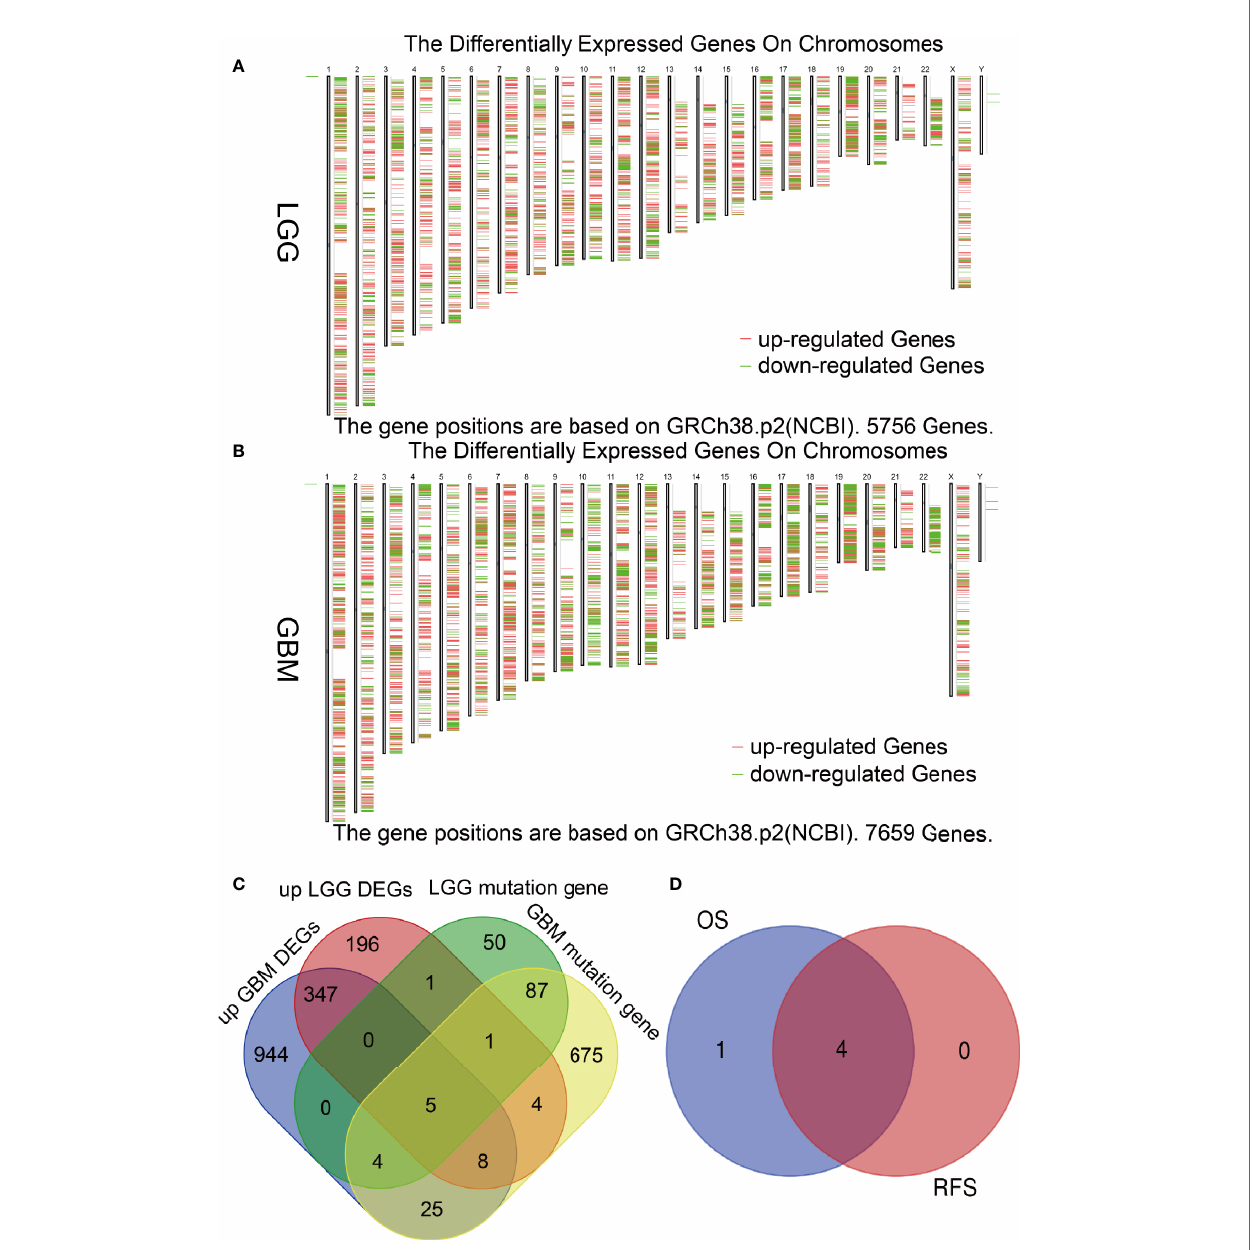
FIGURE 1 | Screening for potential tumor antigens in glioma. (A, B) Identi fi cation of potentially relevant antigens in glioma. Chromosomal distribution of differentially expressed genes in low-grade glioma (LGG) and glioblastoma (GBM). (C) Venn diagram showing the overlapping genes among genes grouped based on up GBM DEGs, genes grouped based on up LGG DEGs, genes grouped based on LGG mutation genes, and genes grouped based on up GBM mutation genes. (D) Statistically signi fi cance of the 5 hub genes for predicting overall survival and relapse-free survival (p <